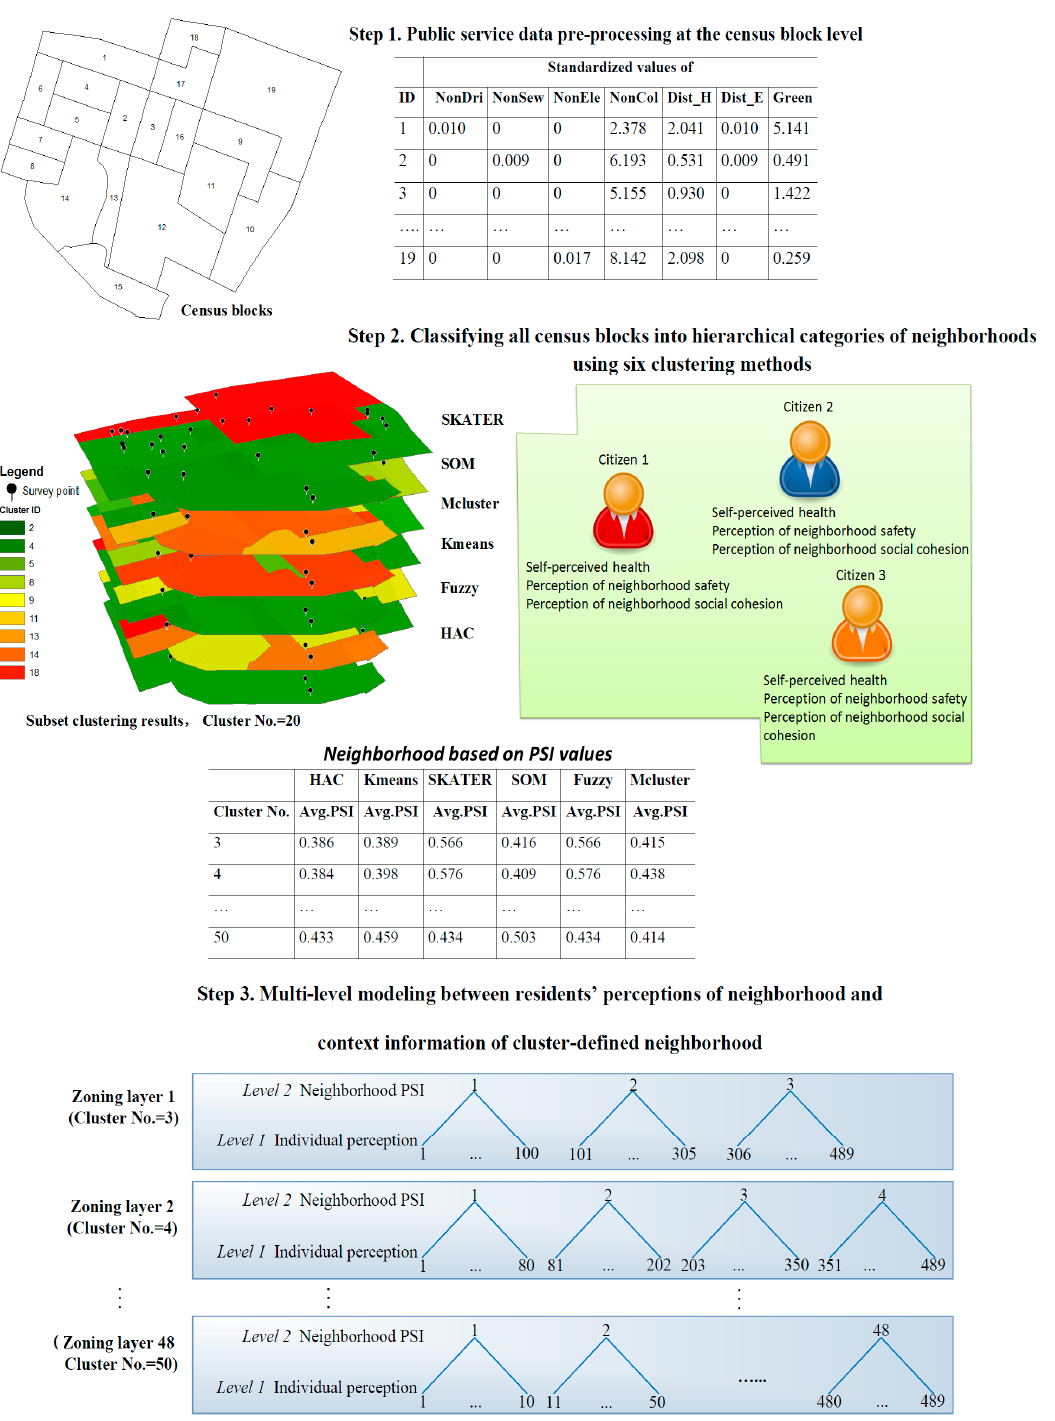
Figure 2. Workflow to produce neighborhoods in terms of Public service inequality indicators.